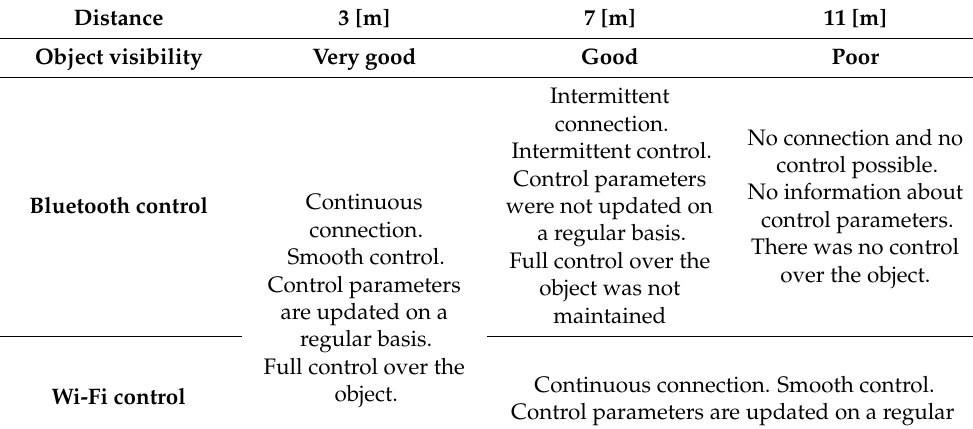
Table 4. List of system performance quality indicators depending on the distance. Distance 3 [m] Object visibility Very